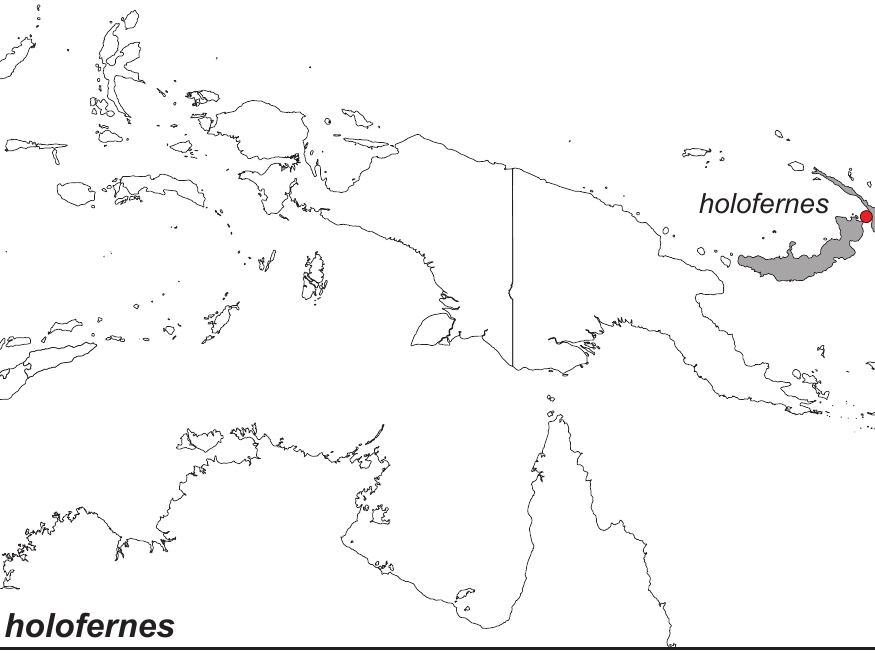
Figure 72. Distribution map of Elymnias holofernes